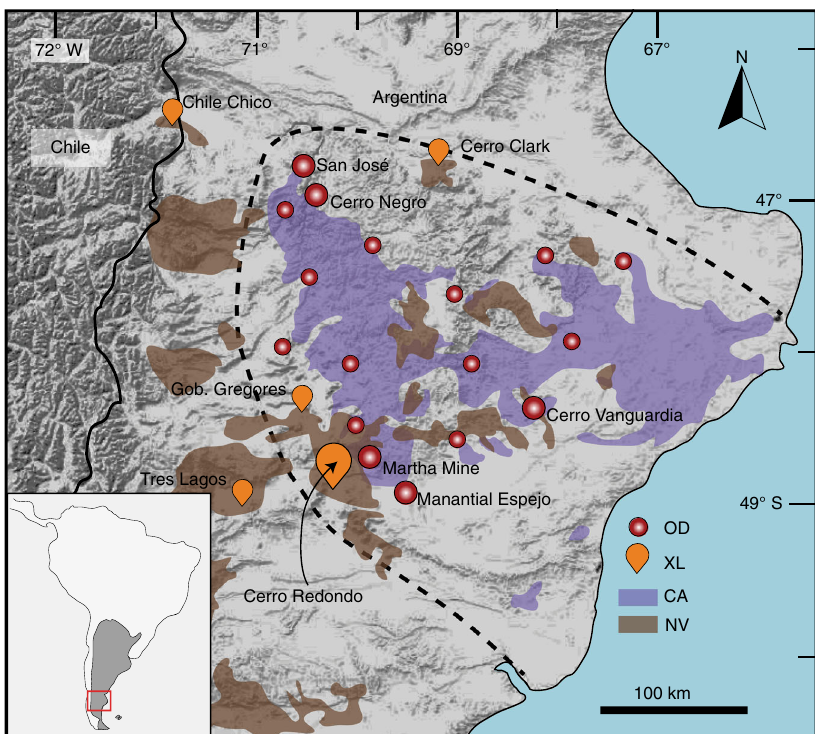
Fig. 1 Simpli fi ed geological map of southern Patagonia Argentina. The dashed line delimits the Deseado Massif auriferous province. CA, Chon Aike volcanic sequences; NV, Neogene volcanism; OD, most relevant ore deposits and prospects; XL, location of different xenolith sites in the Deseado Massif and